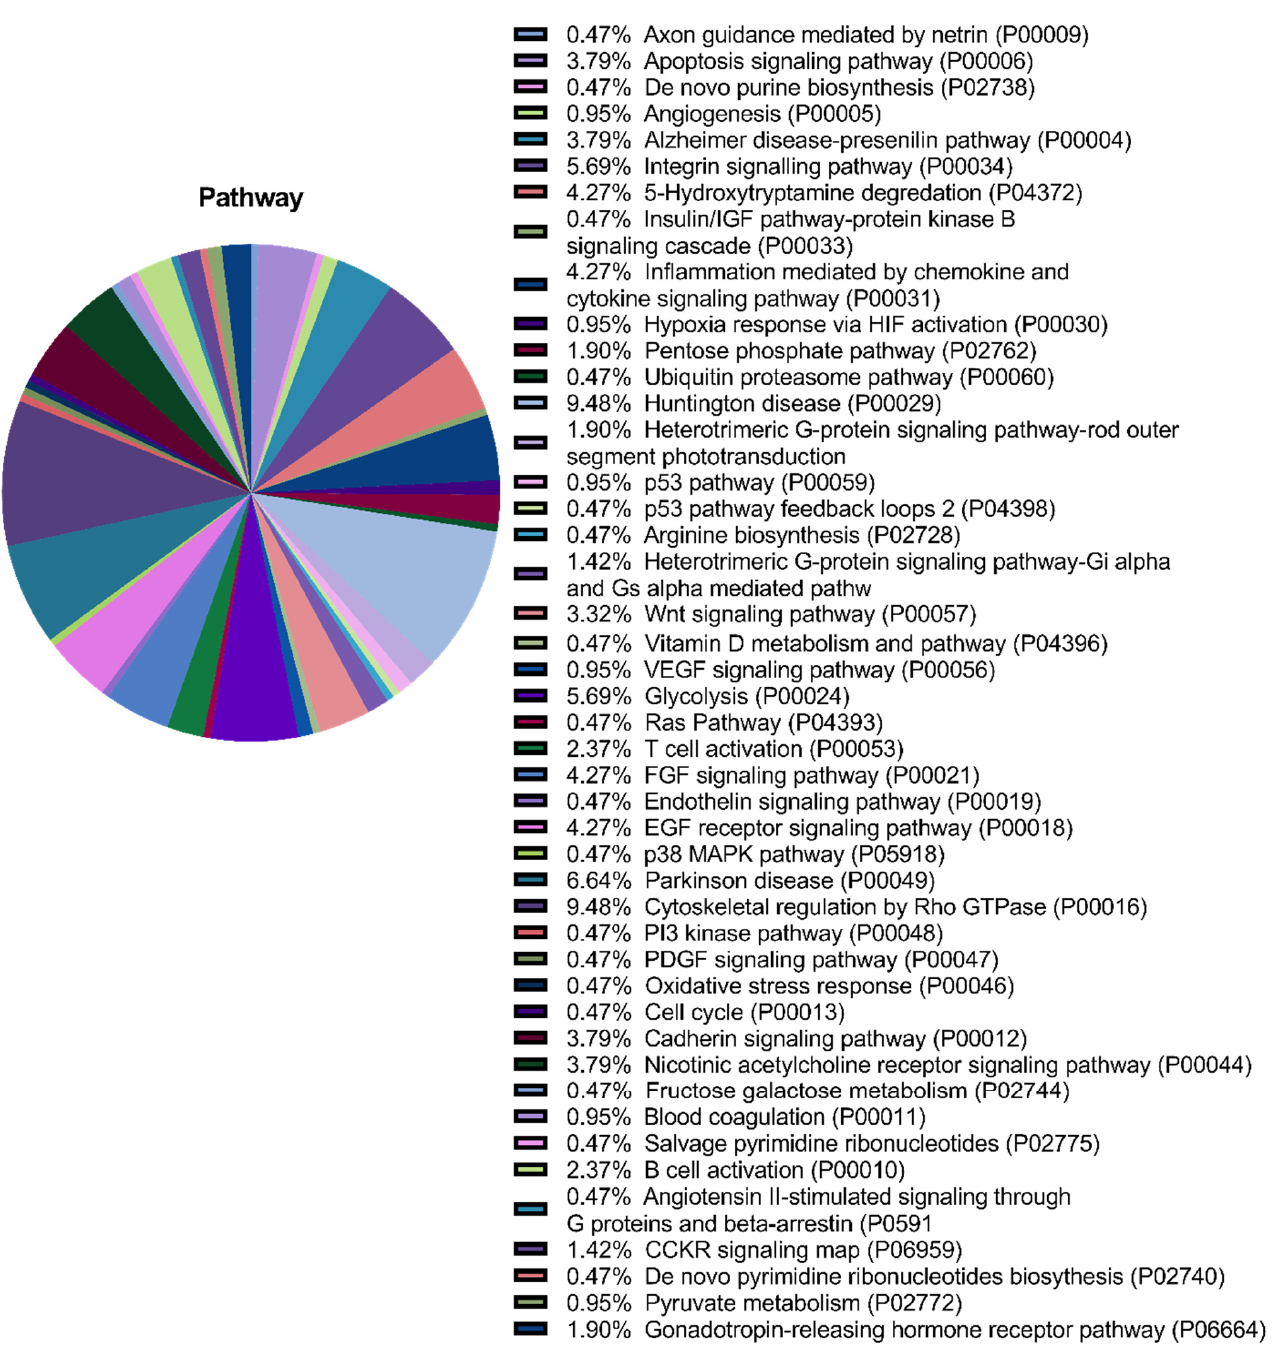
Figure 3. Proteomic analysis of the multipotent mesenchymal stromal cell (MMSC) secretome. Gene ontology pie chart of pathways associated with proteins identified in the secretome from MMSC cell culture.